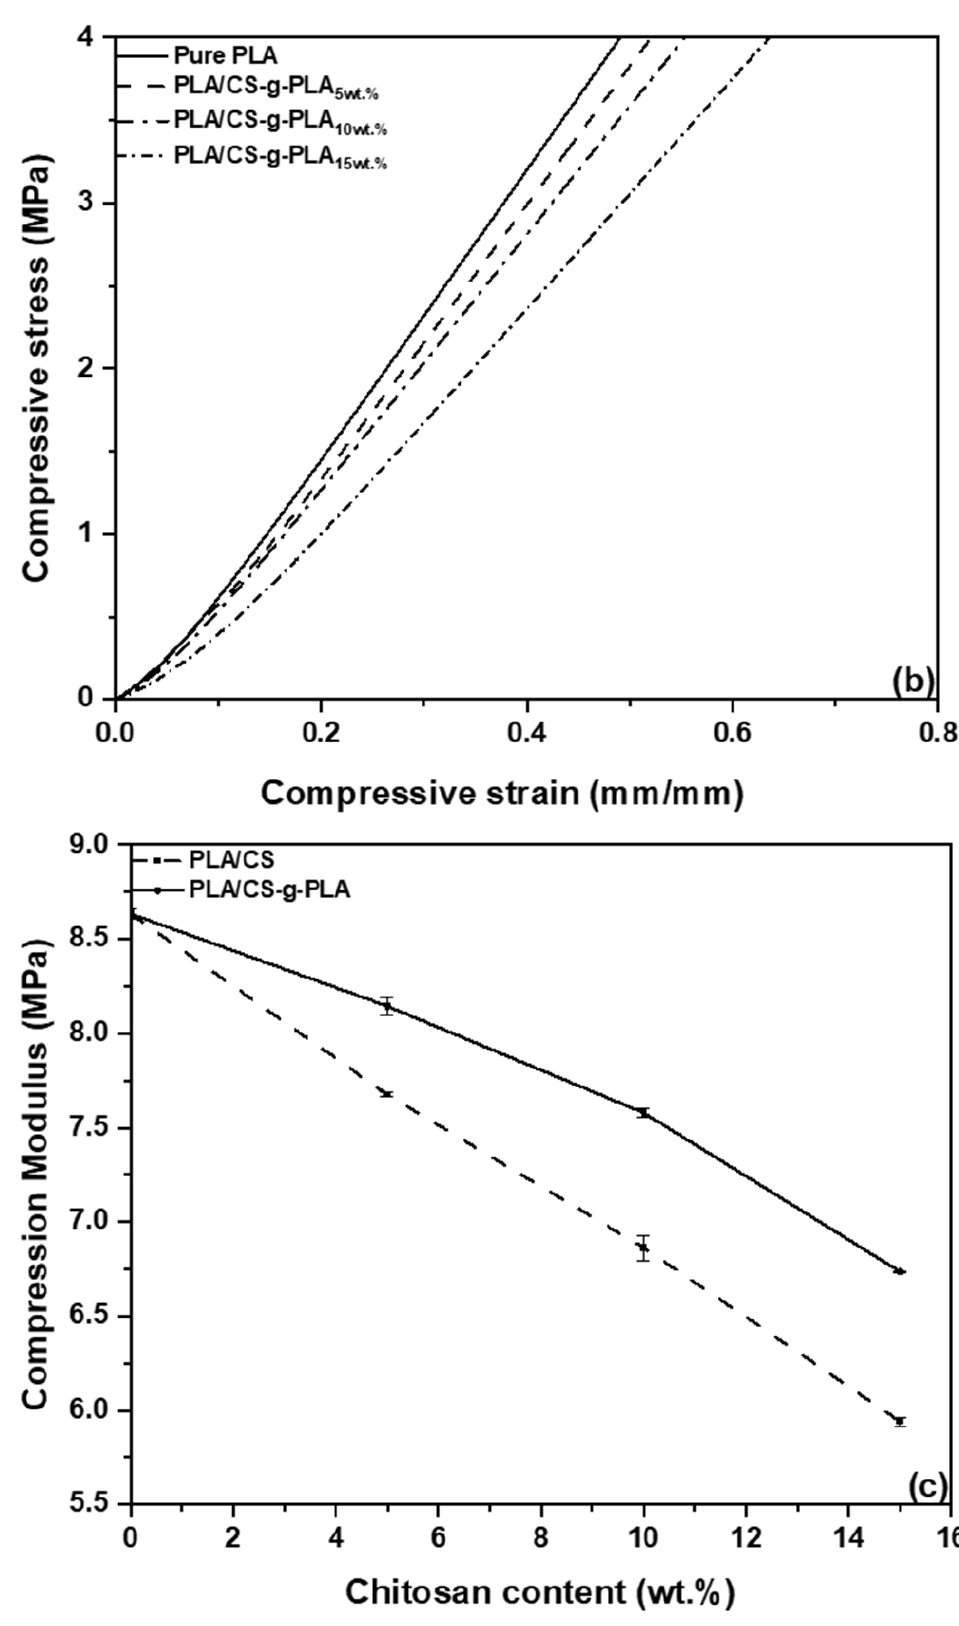
Figure 7. Compression stress-train curves for ( a ) PLA/CS; ( b ) PLA/CS-g-PLA porous scaffolds; and ( c ) their corresponding compression moduli, as a function of CS and CS-g-PLA